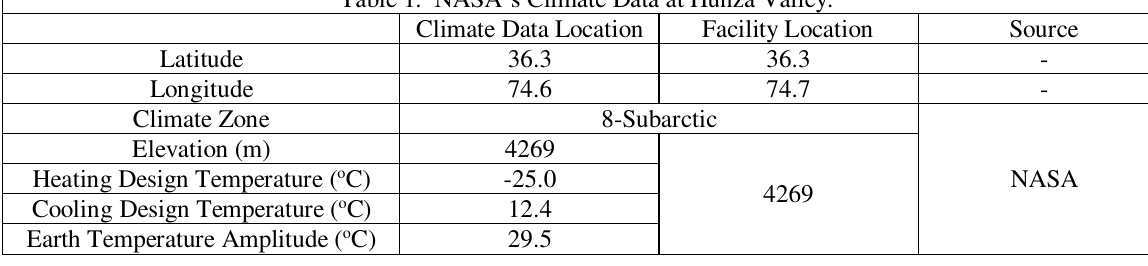
Table 1. NASA’s Climate Data at Hunza Valley.